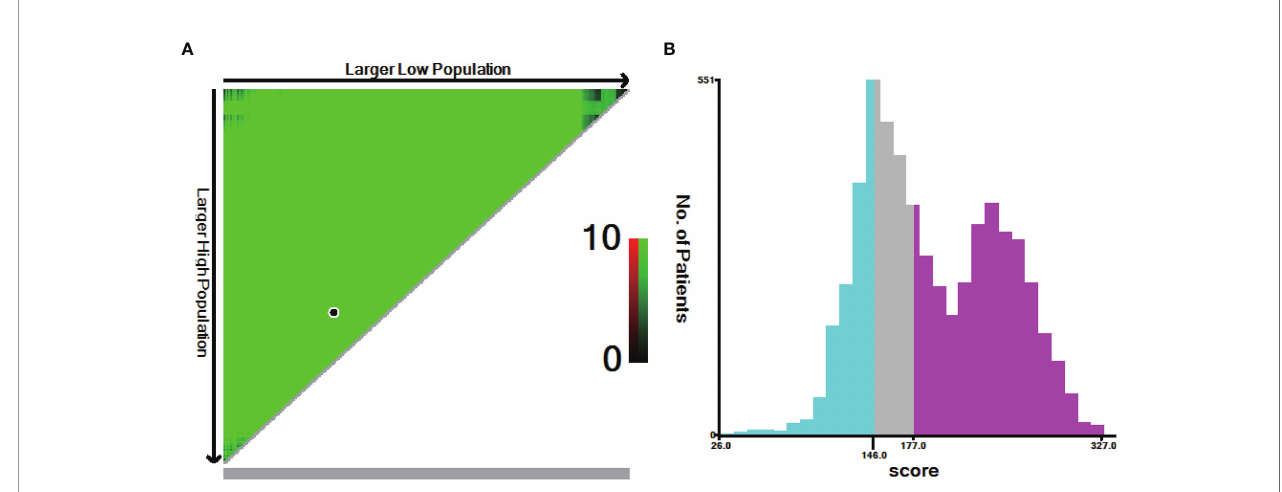
FIGURE 5 | X-tile analysis for risk strati fi cation: (A) The optimal cut-off value; (B) Numbers of patients in low, moderate and high risk